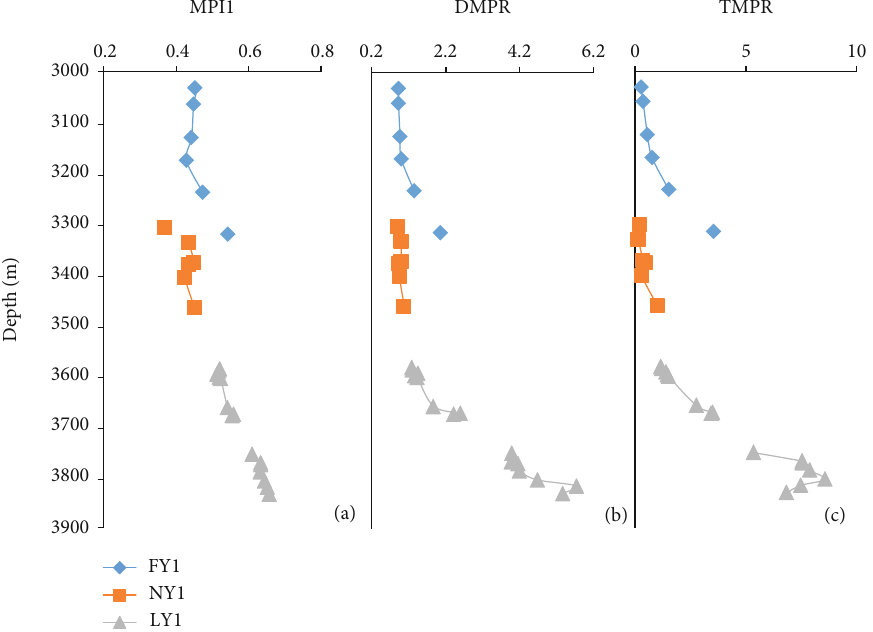
Figure 11: Maturity pro fi le derived from alkylphenanthrenes in the 3 studied wells. (a) Methylphenanthrene Index 1 (MPI1). (b) Dimethylphenanthrene ratio (DMPR). (c) Trimethylphenanthrene ratio